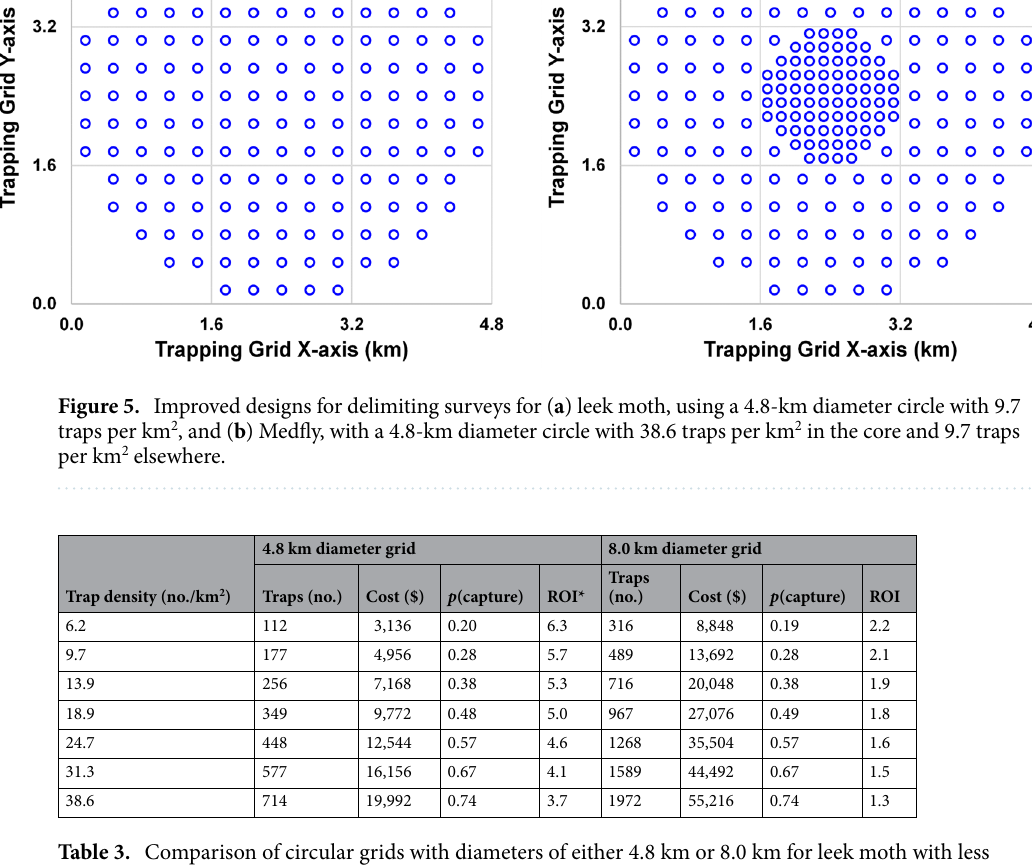
Table 3. Comparison of circular grids with diameters of either 4.8 km or 8.0 km for leek moth with less attractive traps (1/λ = 10 m), showing numbers of traps in the design, costs, the likelihood of capture ( p (capture)), and return on investment (ROI). * ROI: return on investment, capture percentage for each $1,000 spent.